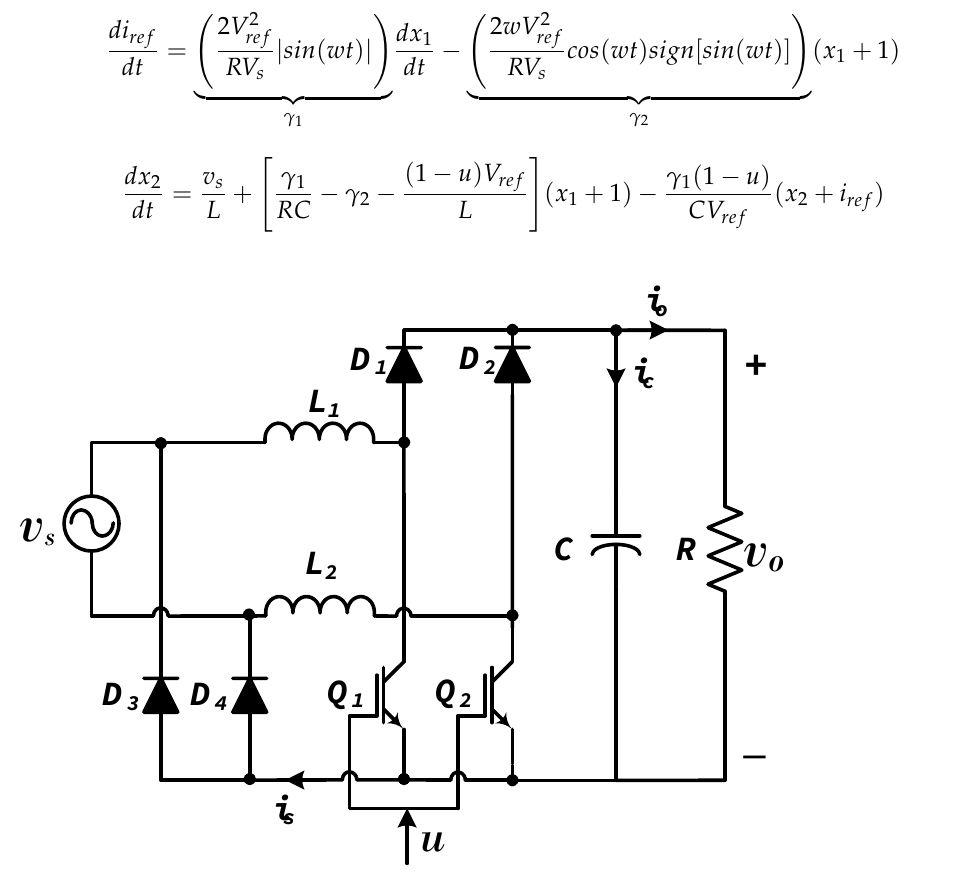
Figure 1. Topology SBBC with clamped